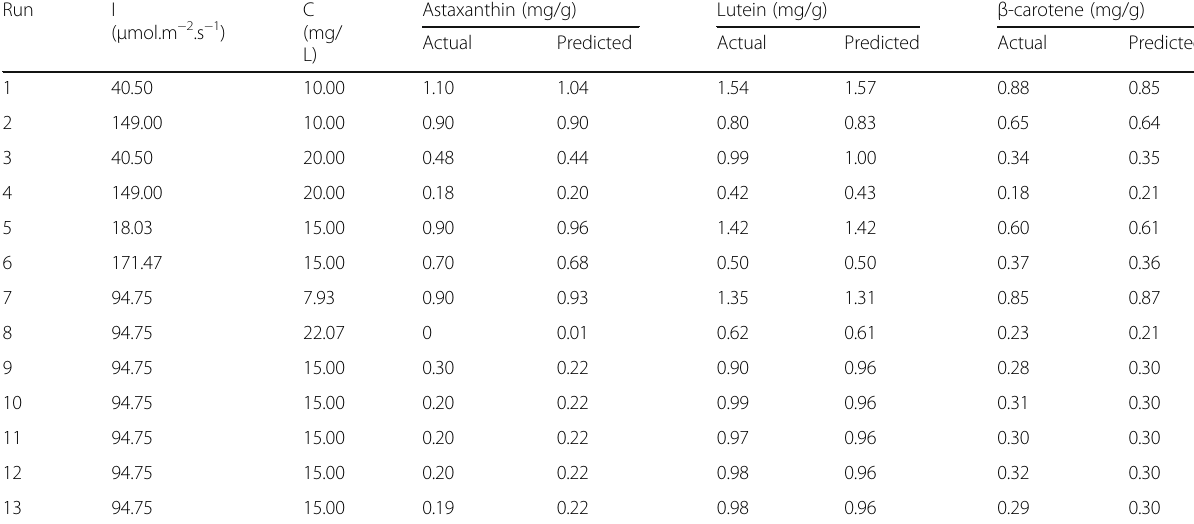
Table 1 Experimental data for five levels of the two-factor response surface analysis Run I ( μ mol.m − 2 .s − 1